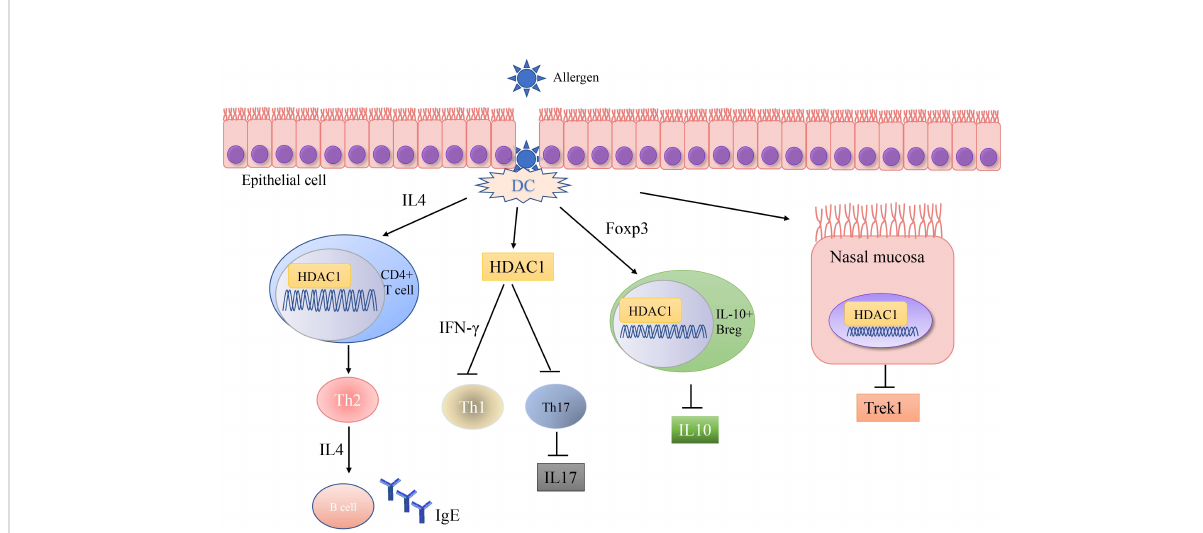
FIGURE 1 Schematic representations of HDAC1 related mechanism in allergic diseases. Allergic disease patients have an epithelial barrier suffering from allergen stimulation. Exposure to allergens activate dendritic cell and increase HDAC1 expression, leading to signi fi cantly increase Th2 cytokine levels, decrease Th1/Th17 cells and anti-in fl ammatory cytokine IL-10, and Trek-1